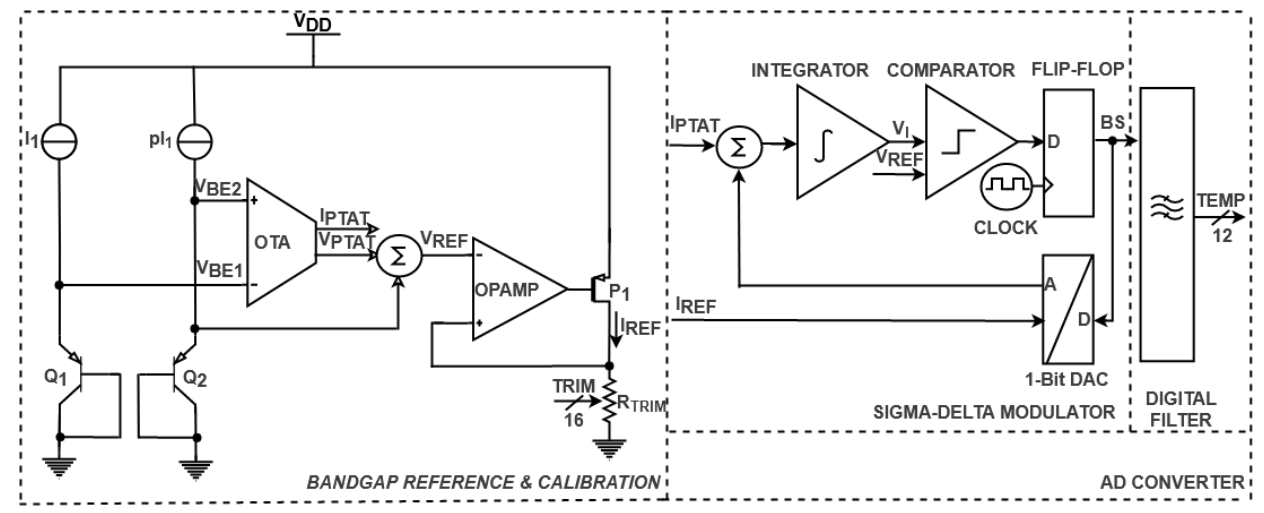
Figure 4. Detailed temperature sensing circuitry of DTS .